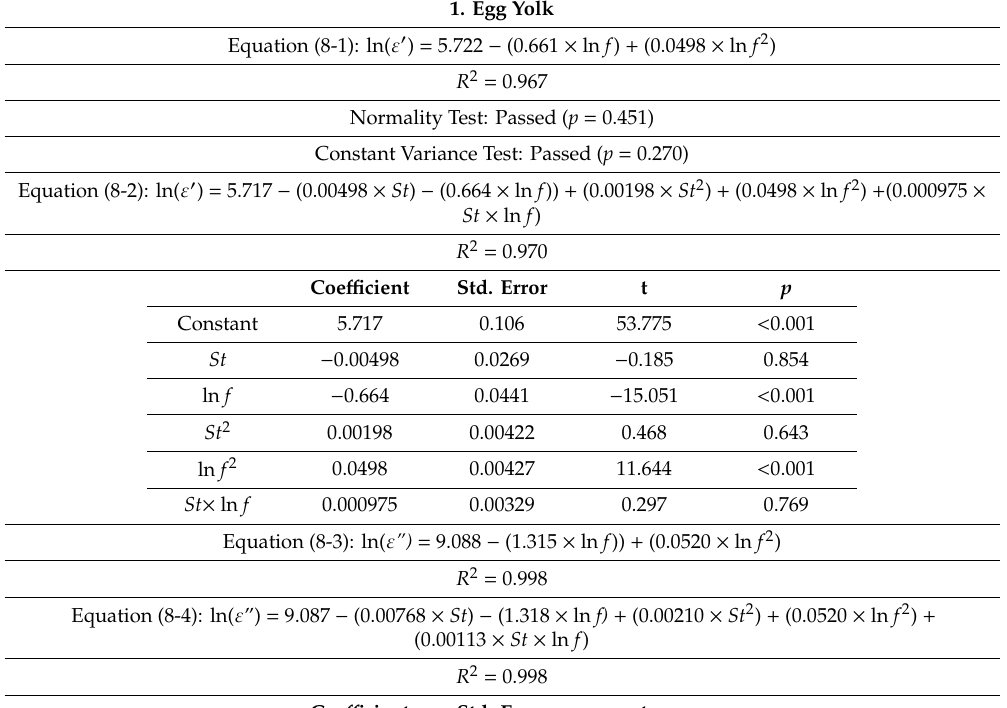
Table 8. Study of the e ff ect of the storage time on the dielectric properties of eggs using regression